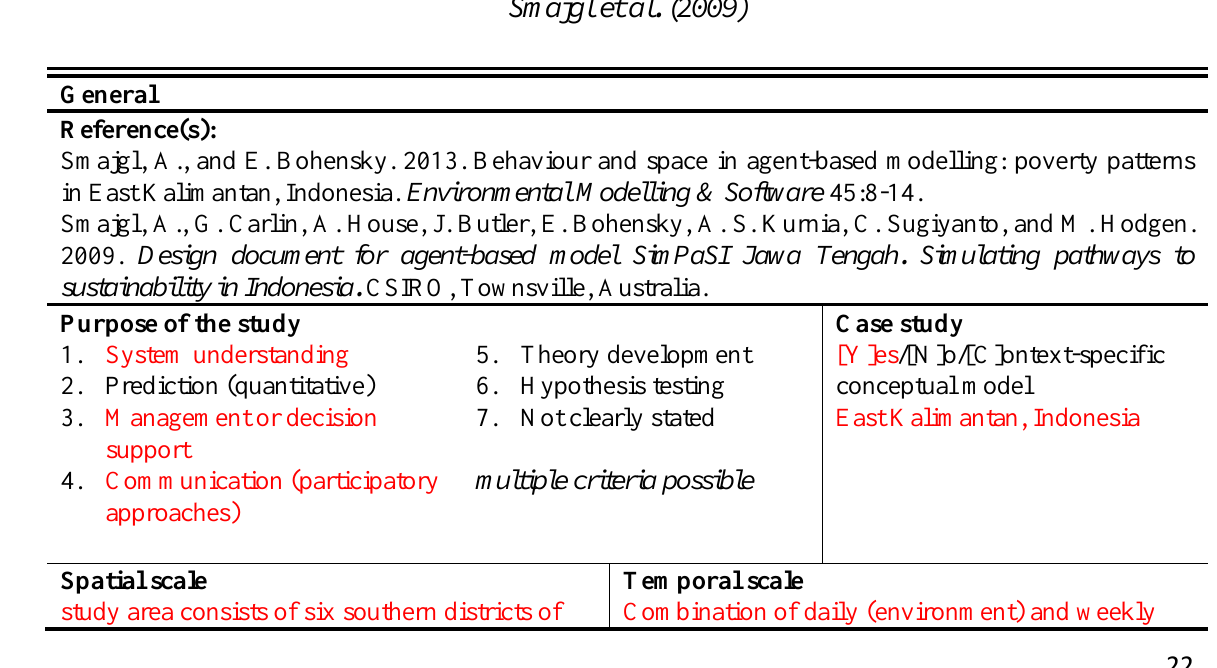
Table A1.11 Standardized protocol for the ABM described by Smajgl & Bohensky (2013)